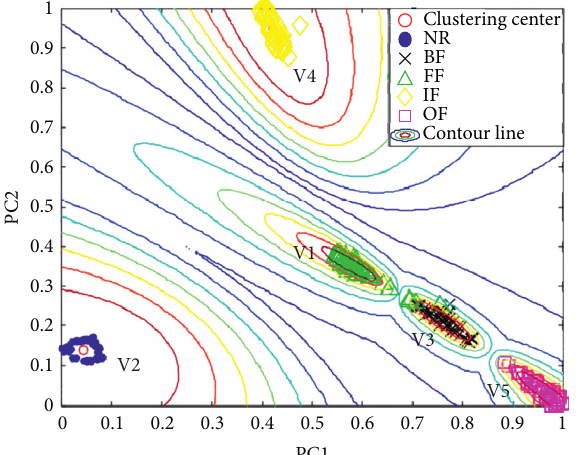
Figure 15: The cluster contour map of the proposed